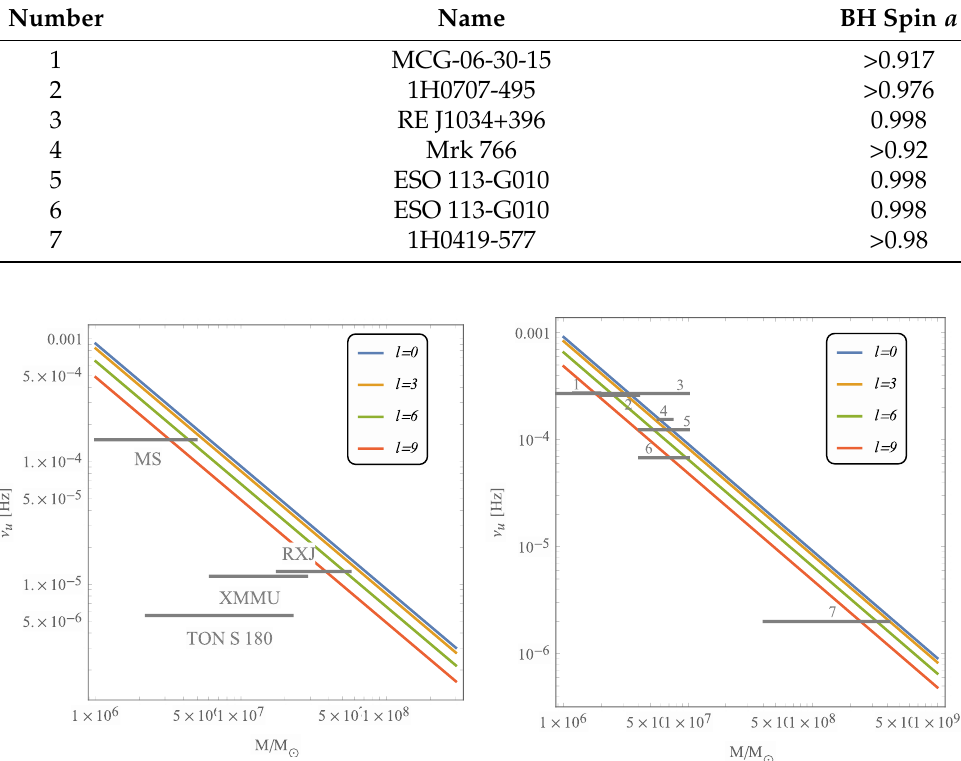
Figure 10. Fit of 3:2 frequencies ratio to mass estimate of assumed supermassive black holes in active galactic nuclei for various values of the parameter l giving Simpson–Visser wormholes. Sources with unknown rotation estimates are marked on the left panel. On the right panel are sources with known estimate of spin listed in Table 1 (cf.